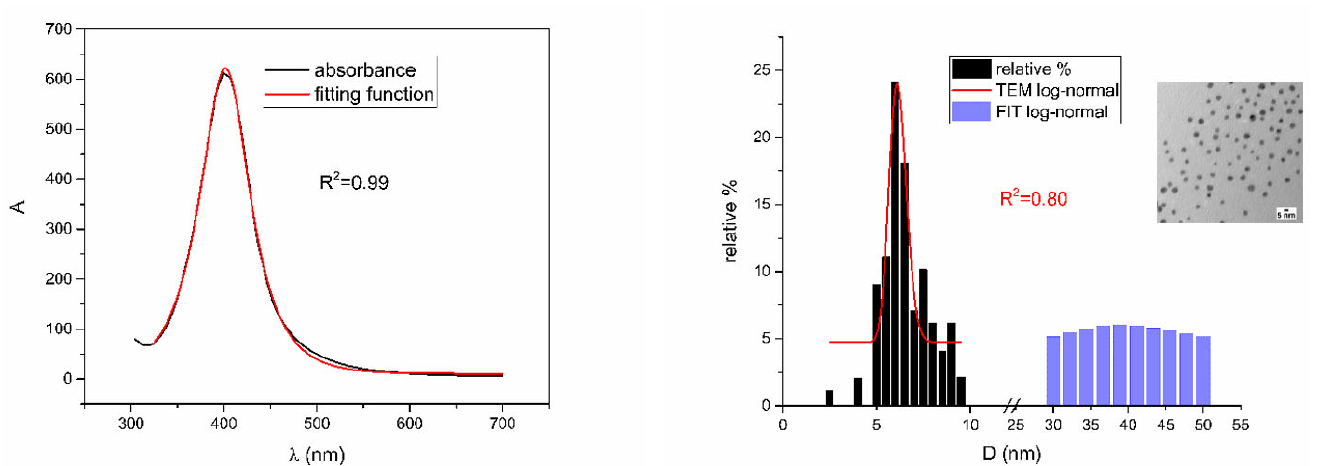
structed size distributions are shown on the ( right ). An additional TEM image is also shown.